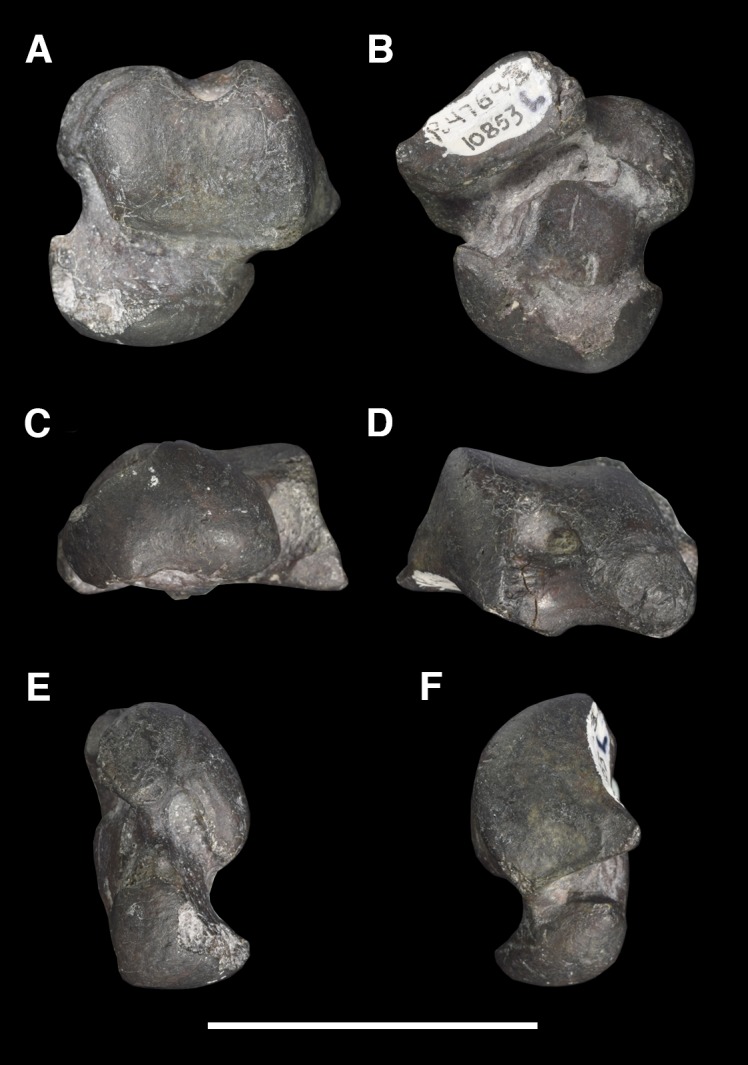
Left astragalus of Periptychus carinidens (NMMNH P-47693).(A) dorsal view; (B) plantar view; (C) anterior view; (D) posterior view; (E) medial view, (F) lateral view. Scale bar: 30mm.